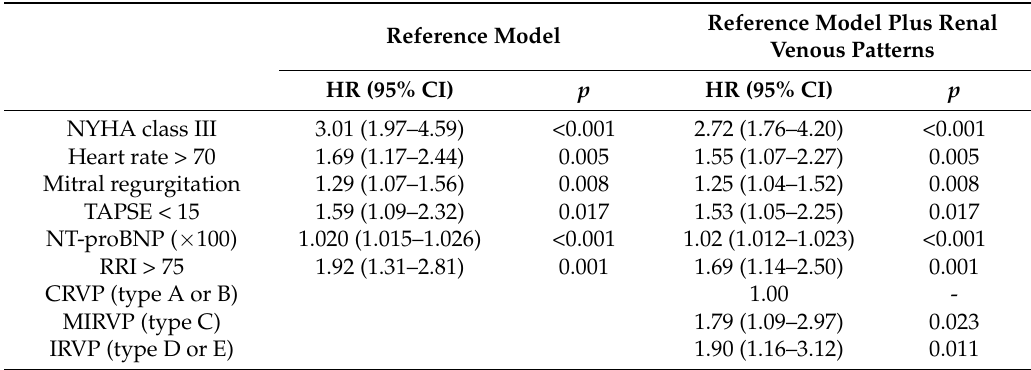
Table 3. Reference model derived by using a forward stepwise Cox analysis where renal venous patterns categories have been